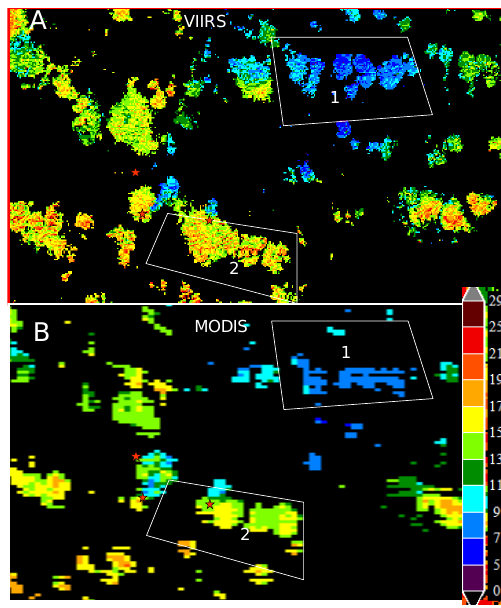
Fig. 8. VIIRS and MODIS retrieved effective radius for the clouds shown in Fig. 6. Only clouds with 0.6µm solar reflectance >0.4 are analyzed.